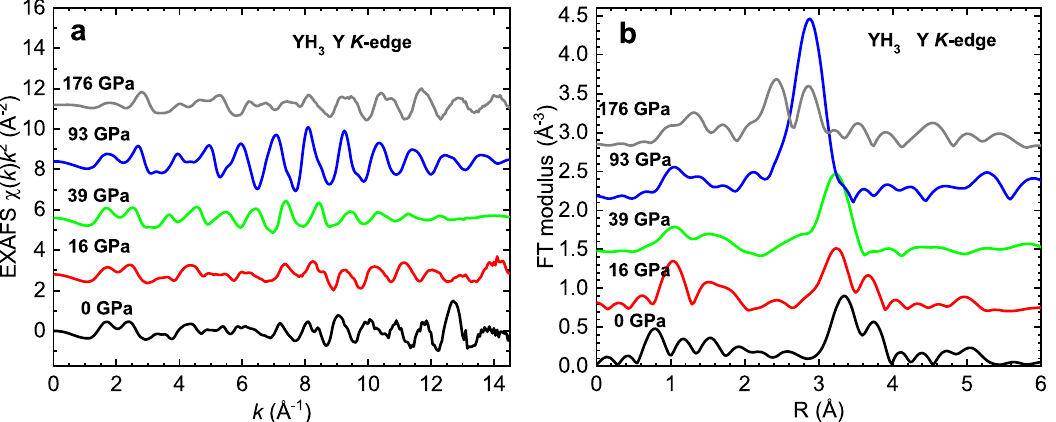
Fig. 5 Pressure-dependent EXAFS spectra of YH 3 . a EXAFS spectra χ ( k ) k 2 of YH 3 at the K -edge of Y, and b their Fourier transform moduli at different pressures up to 176 GPa. The FTs represent raw experimental data without corrections for the scattering phase shifts due to the photoelectron